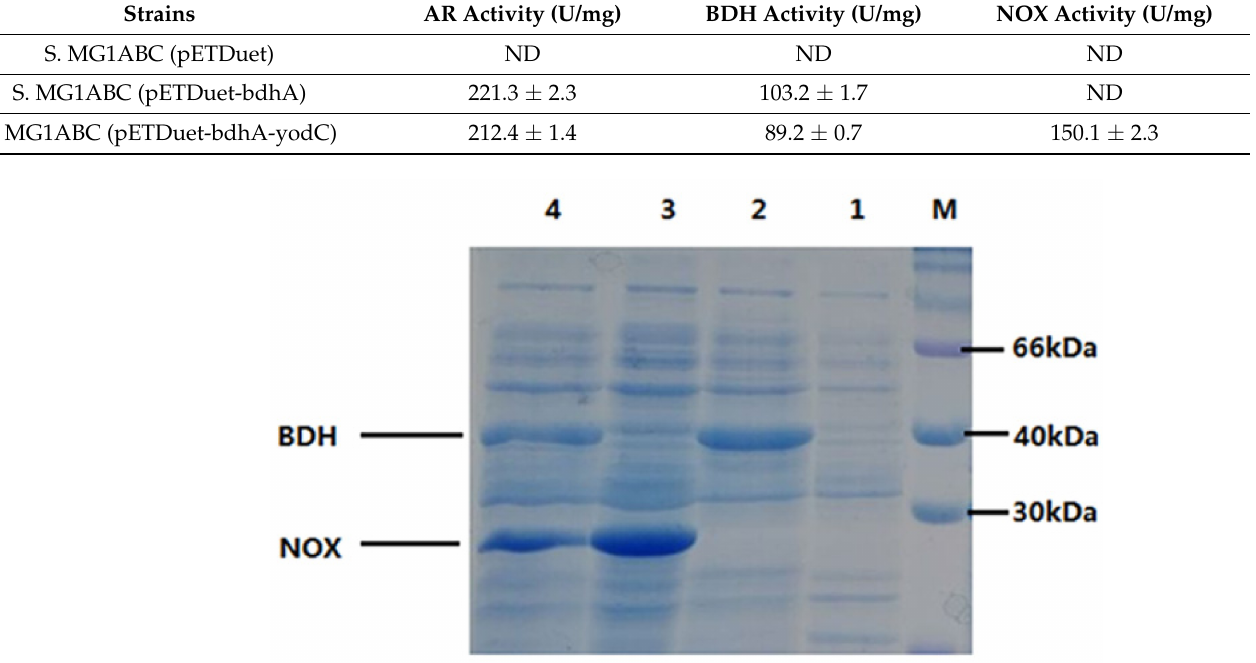
Figure 7. Validation of the expression of 2,3-BDH and NOX in Serratia marcescens through SDS- PAGE. M, maker; lane 1, Serratia marcescens MG1ABC (pSWNB+pETDuet); lane 2, Serratia marcescens MG1ABC (pSWNB+pETDuet-bdhA); lane 3, Serratia marcescens MG1ABC (pSWNB+pETDuet-yodC); lane 4, Serratia marcescens MG1ABC (pSWNB+pETDuet-bdhA+yodC).